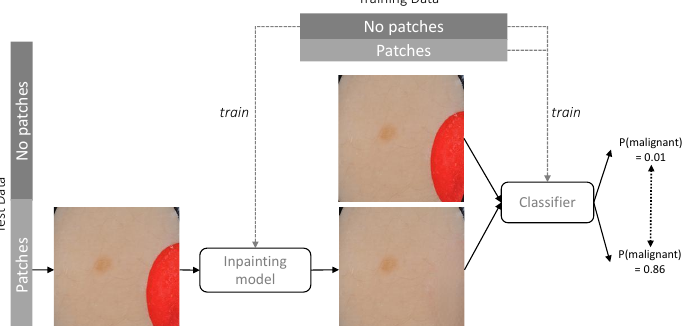
Figure 2. Methodology for assessing the extent to which the classifier relies on coloured patches for predicting a benign case. The classifier is trained on the full training set, the inpainting model is trained with training images without patches. The classifier is tested on both the unaltered test set and after replacing patches with inpainted skin.